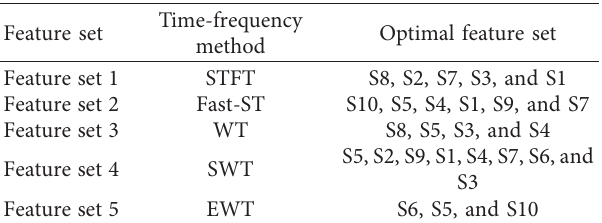
Table 7: Selected features by forward selection technique for different feature sets.